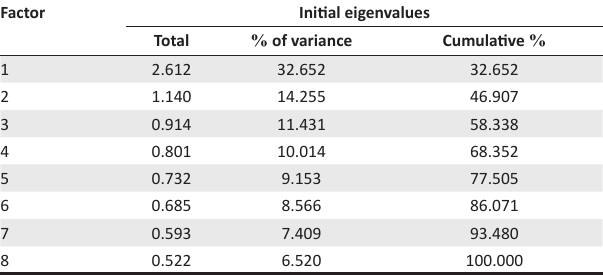
TABLE 11: Initial eigenvalues: relational capital disclosure (second-level factor analysis).